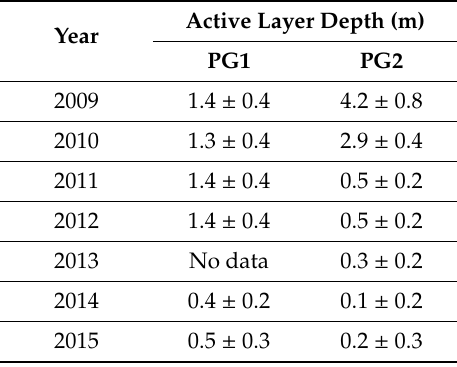
Table 4. Active layer thickness for boreholes PG1 and PG2 from 2009 to